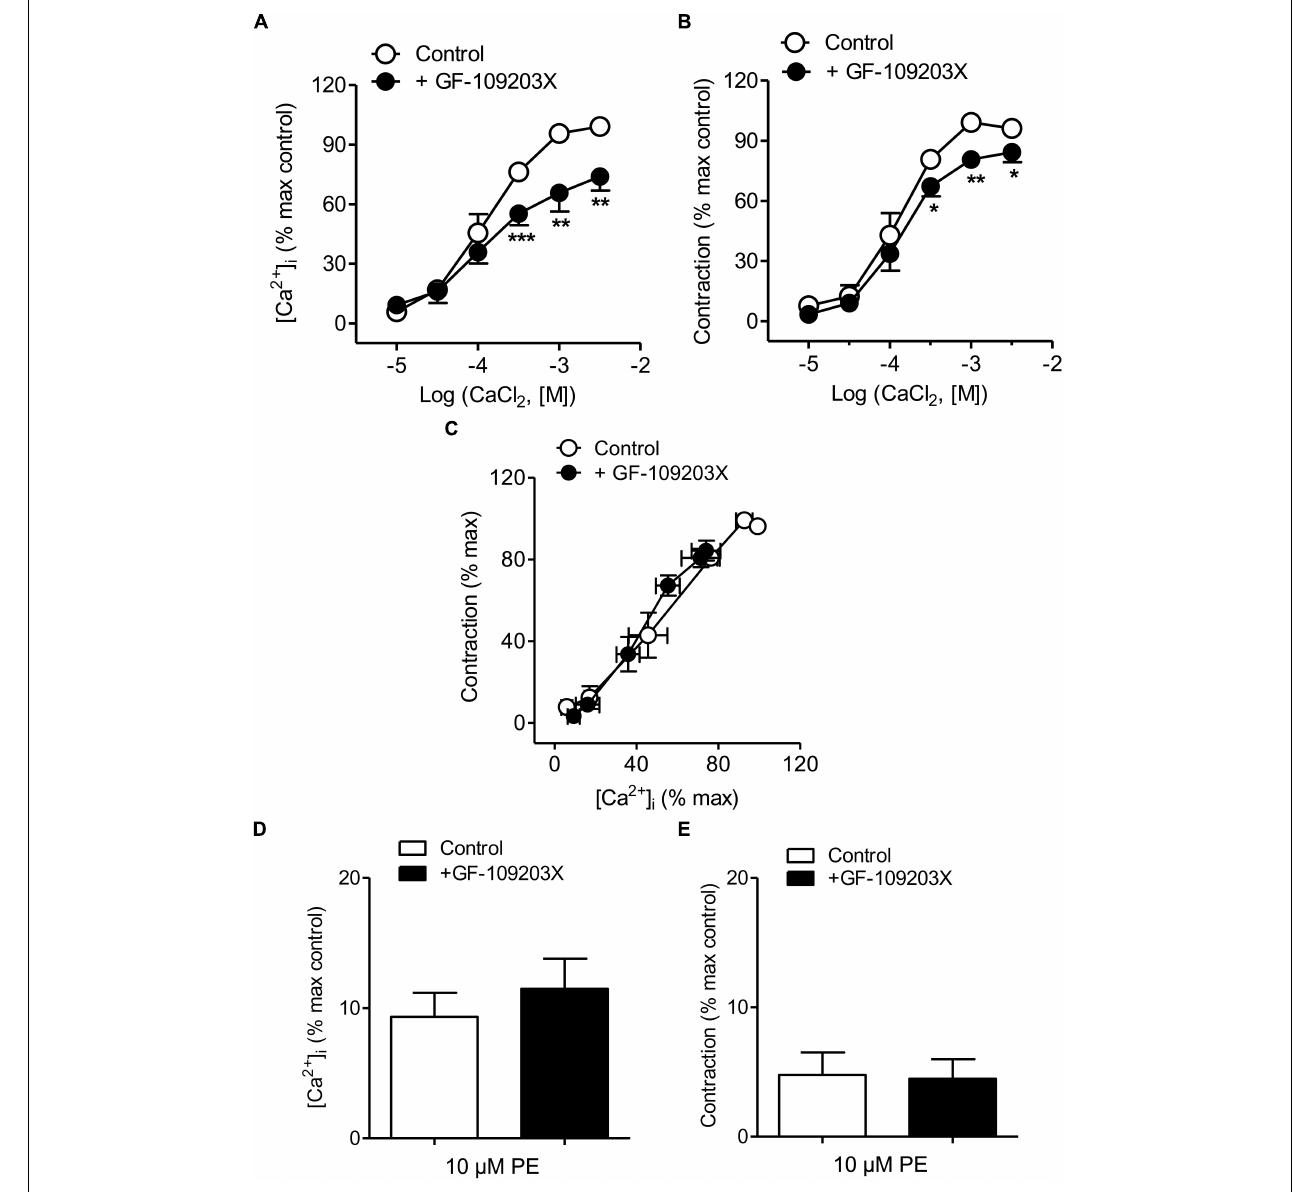
FIGURE 5 | PKC inhibition reduced Ca 2 + entry and vasoconstriction without changing Ca 2 + sensitization elicited by α 1 -adrenoceptor activation. (A,B) Average effects of the PKC inhibitor GF-109203X (0.1 µ M) on the increases in [Ca 2 + ] i (A) and contraction (B) elicited by cumulative addition of CaCl 2 in endothelium-denuded arteries kept in a Ca 2 + -free medium and stimulated by 10 µ M PE. (C) Effect of GF-109203X on the [Ca 2 + ] i -contraction relationships for PE in mesenteric resistance arteries and (D,E) on the increases in [Ca 2 + ] i and contraction elicited by 10 µ M PE in in Ca 2 + -free PSS. Results are expressed as a percentage of control maximal responses. Values are means ± SEM of n = 7 arteries (one from each animal). ∗ P < 0.05, ∗∗ P < 0.01, ∗∗∗ P < 0.001 vs.